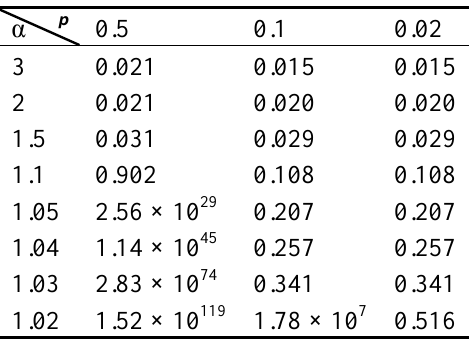
Table 3. Sample l p averages calculated by Algorithm 1 with window size 2 q + 1 = 19 for 2000-point data set from Distribution